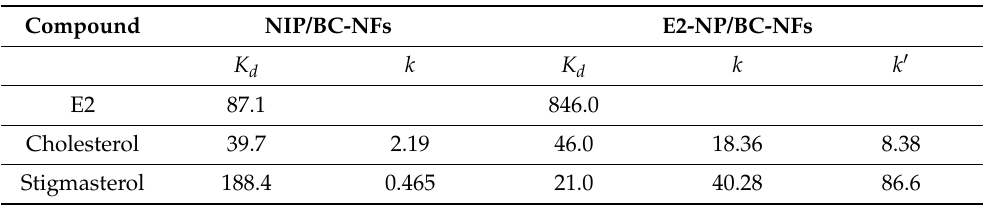
Table 1. Selectivity coefficients ( k ); relative selectivity coefficients ( k (cid:48) ) and values of E2-NP/BC-NFs and NIP/BC-NFs.